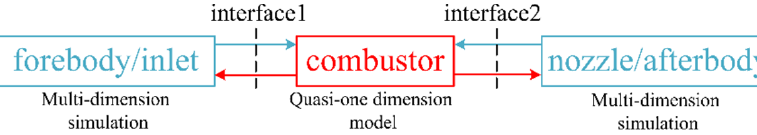
Figure 2. Coupling procedure of the multifidelity simulation method.